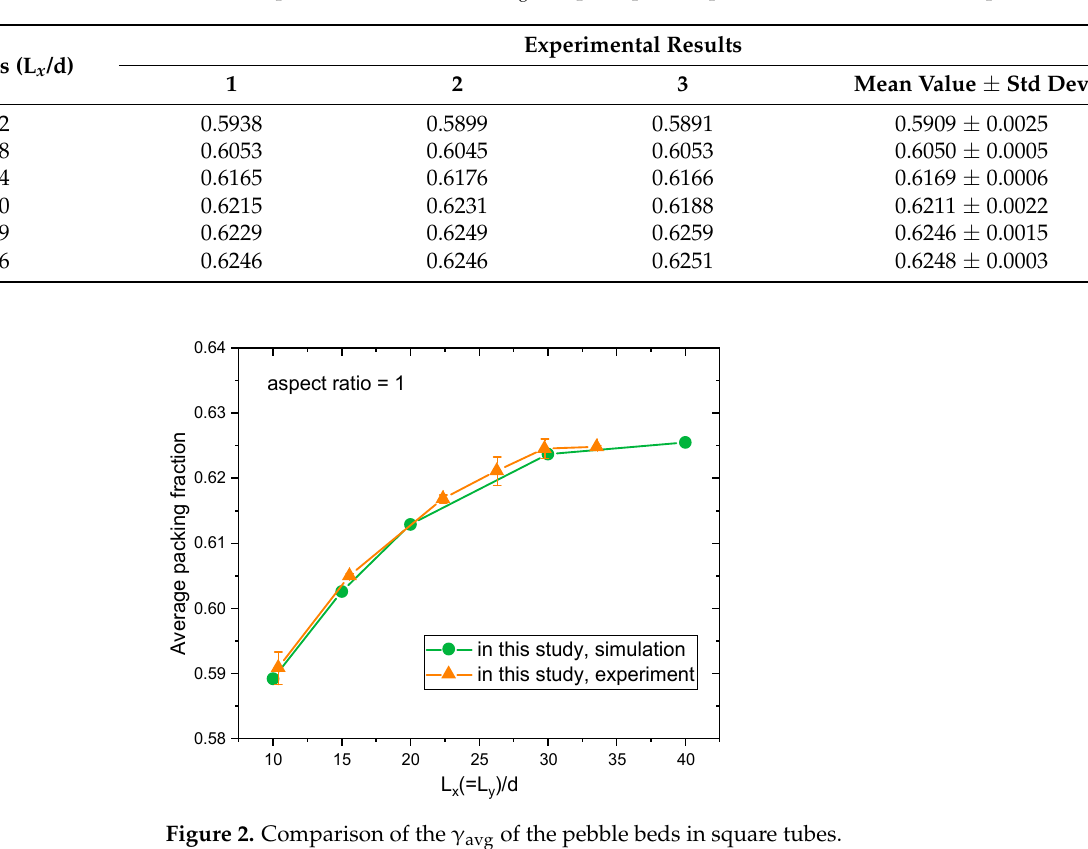
Table 3. Experimental results of γ a vg of square packed pebble bed with different aspect ratios.